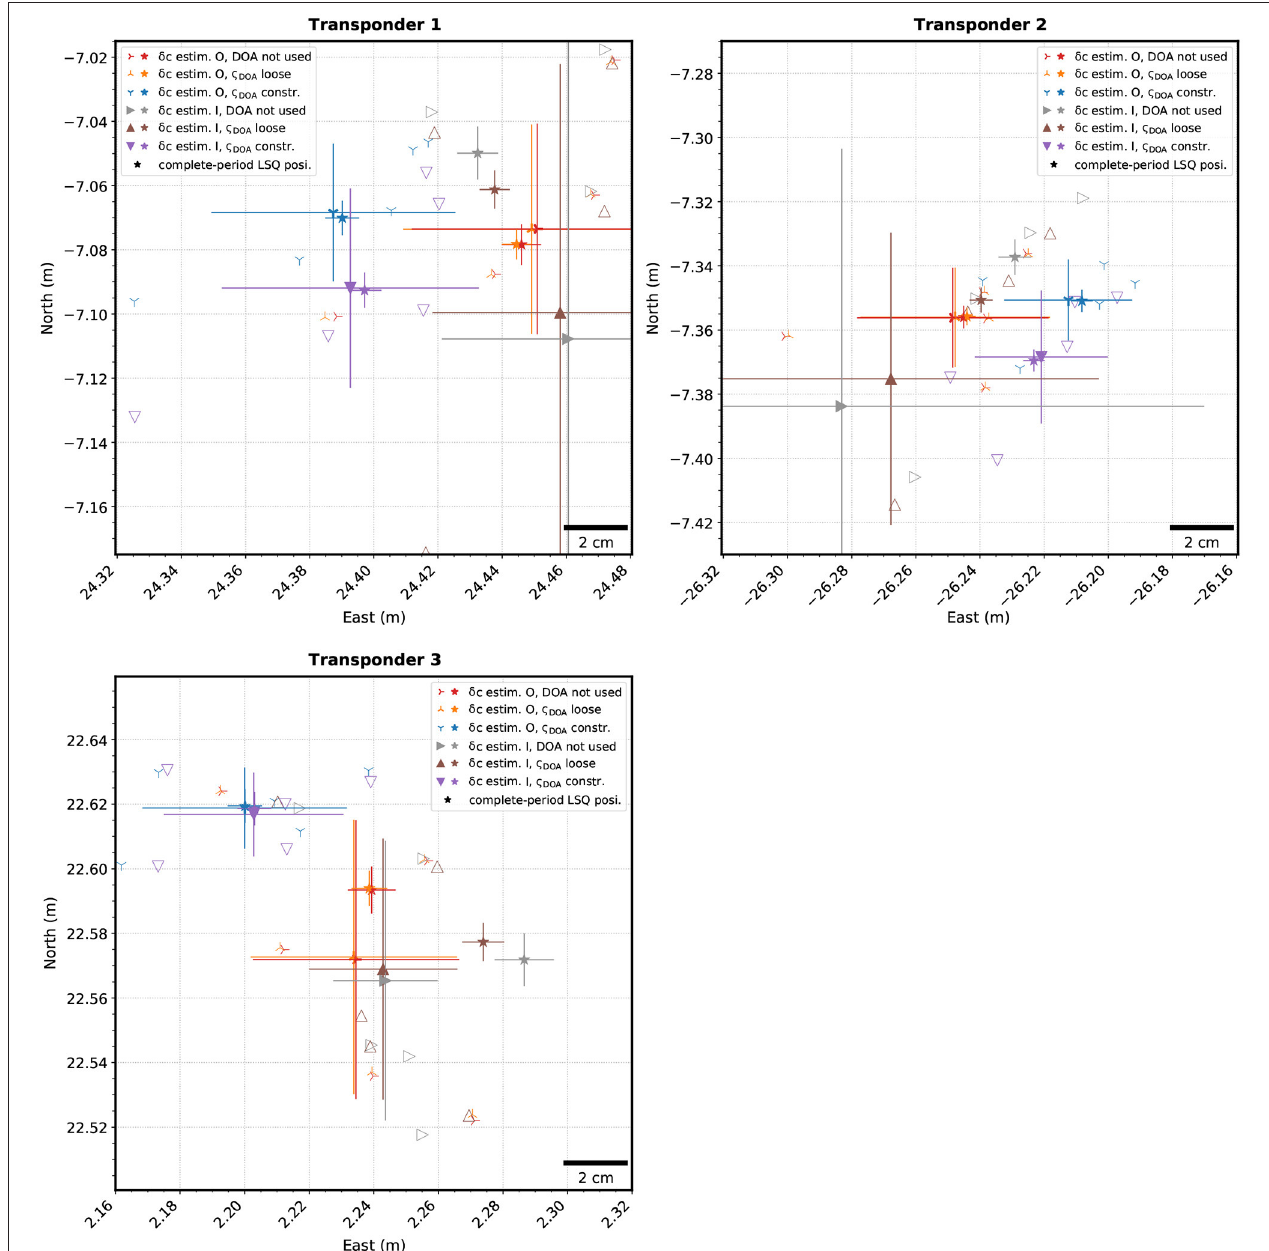
FIGURE 6 | Positions of the three transponders based on the box-in acquisitions, in a local topocentric reference frame. The thin tripod symbols ( , , ) and empty triangles ( , , ▽ ) represent the LSQ inversion results for each of the five data subsets. The equivalent bold/thick symbols represent the arithmetic means of the five △ subset-derived positions with their standard deviations. The colored-star ( H ) represents the result of the LSQ inversion and its formal standard deviation, based on the entire dataset; colors correspond to the different parameterizations used. For the δ c estimation, “I” stands for used, and “O” for not used. Few outlier solutions are outside the frame.